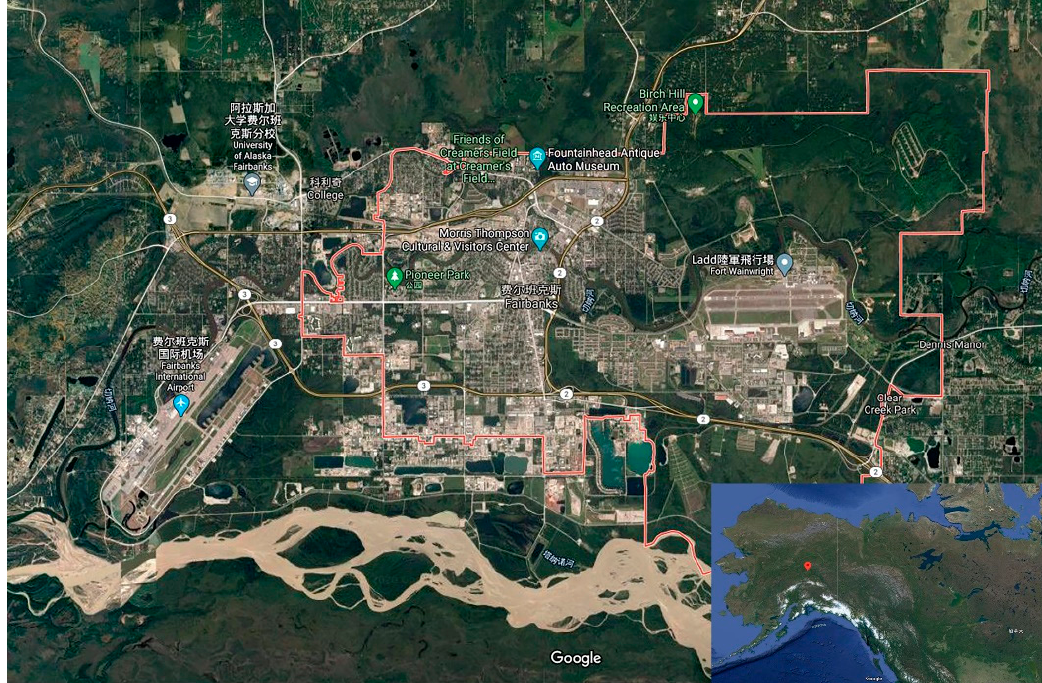
Figure 1. Study region. Map in the bottom right corner shows the NW North American outline, with Fairbanks marked by the red teardrop. (Maps from https://www.google.com/maps).